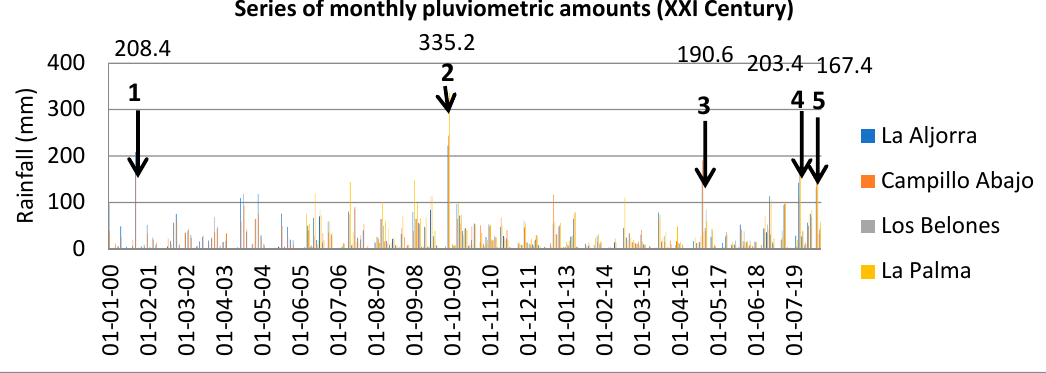
Figure 8. Series of monthly accumulated rainfall in meteorological stations within the watersheds studied.